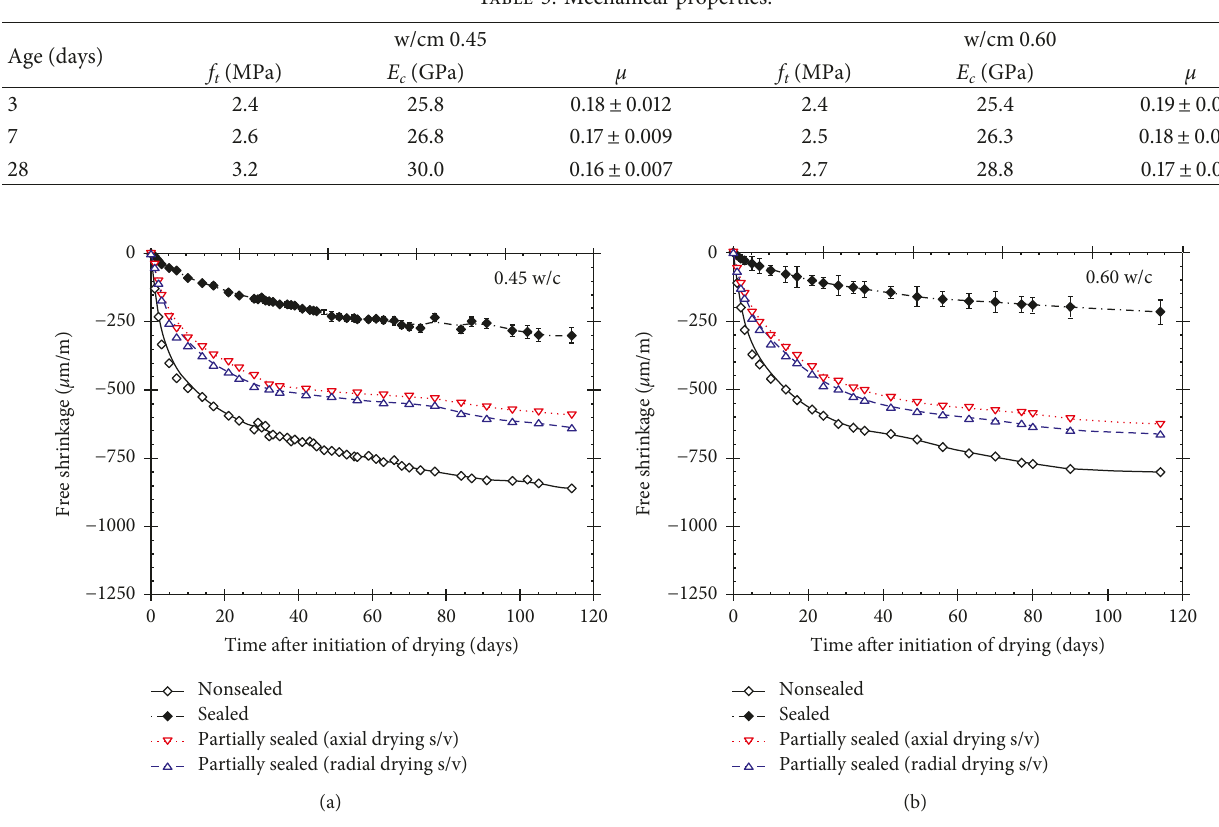
Figure 6: ASTM C157 modified shrinkage strain results obtained under various drying exposure conditions. (a) w/cm 0.45 mixture, (b) w/cm 0.60